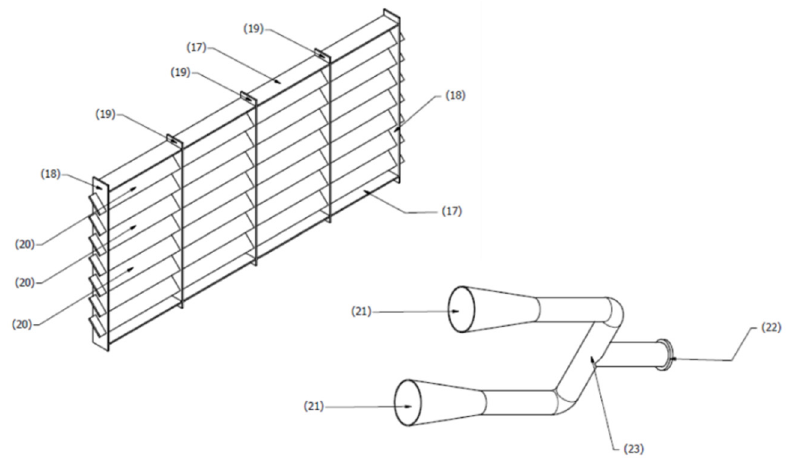
Figure A2. Air diffuser system and air ejectors of the fixed-bed bioreactor. Source: References [18,19].